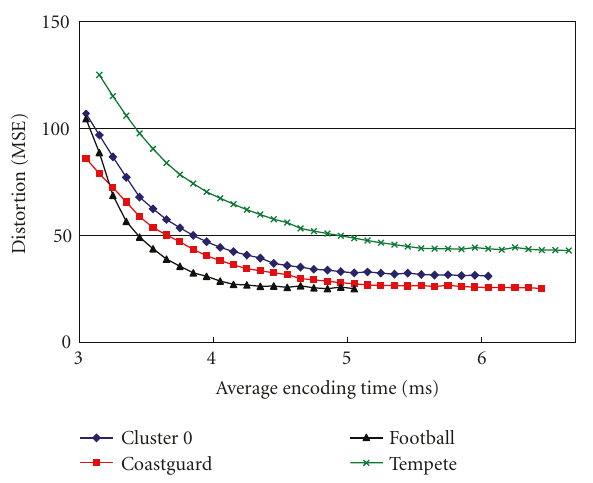
Figure 10: The relationship between average encoding time and distortion for video sequences in cluster 0.